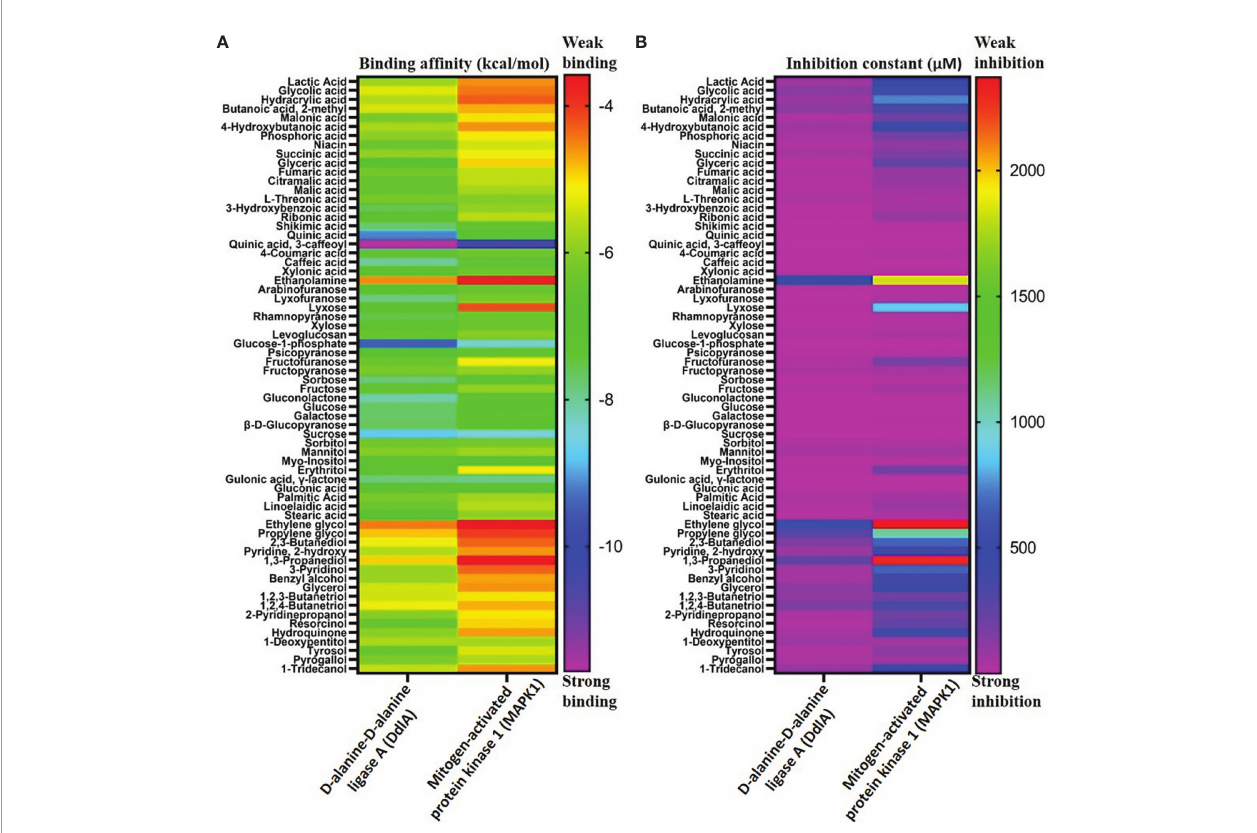
FIGURE 5 | Binding af fi nity of different metabolites with DdlA ( Xoo ) and MAPK1 ( M oryzae ) protein (A) . Inhibition constant of metabolites with DdlA ( Xoo ) and MAPK 1 ( M. oryzae ) protein (B) . Pink and red color representing strong and weak binding af fi nity, respectively. Heat map represents the strong binding af fi nity and inhibition constant of metabolites with DdlA ( Xoo ) than MAPK1 ( M. oryzae ).